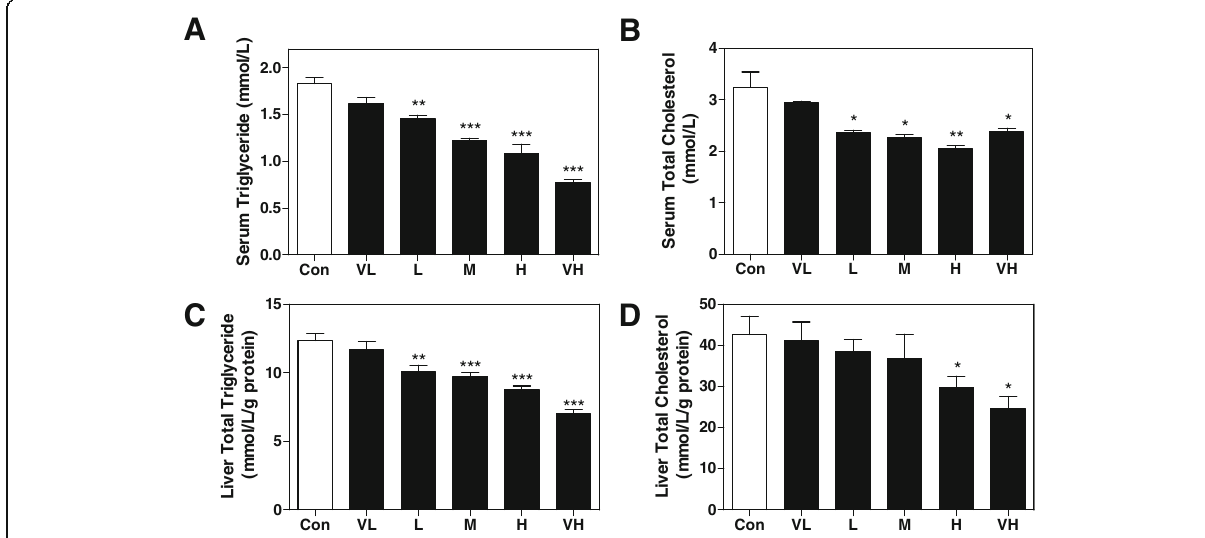
Fig. 6 Effect of SS on lipid contents in serum and liver. a TG and b total cholesterol in serum, and c TG, d total cholesterol level in liver. All results are presented as mean ± S.E. ( n = 8), * p < 0.05 , **p < 0.01 , ***p < 0.001 , compared to vehicle control